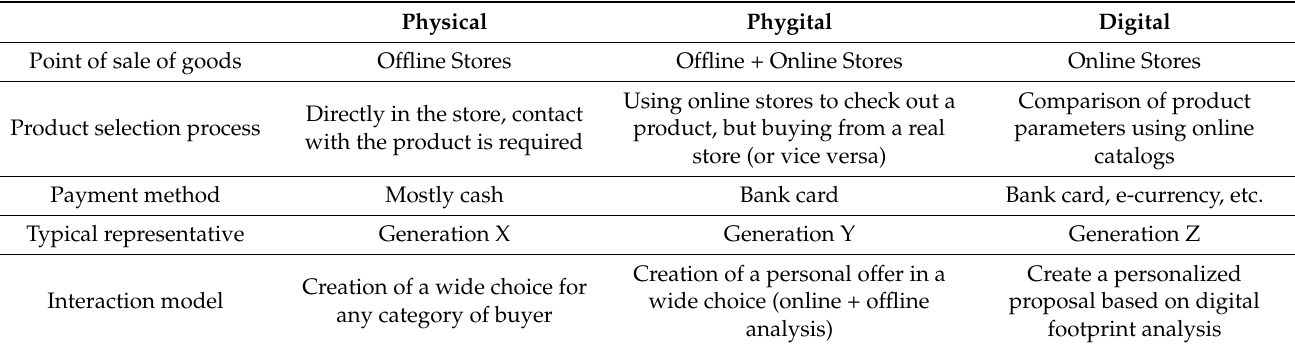
Table 1. Comparison of physical, phygital, and digital environments.